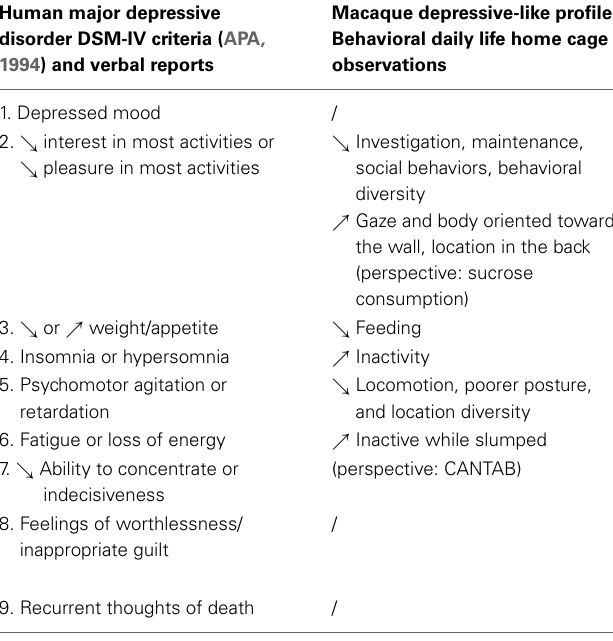
Table 2 | Summary of depressive-like features reported in single- and socially-housed rhesus and cynomolgus macaques and similarities with human depressive